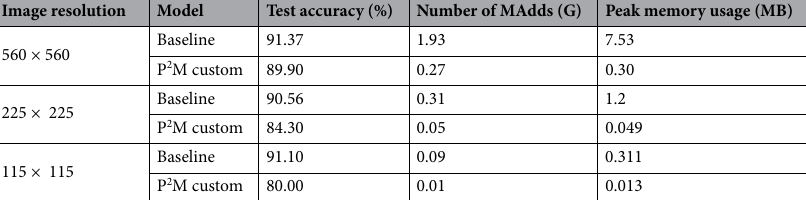
Table 2. Test accuracies, number of MAdds, and peak memory usage of baseline and P 2 M custom compressed model while classifying on the VWW dataset for different input image